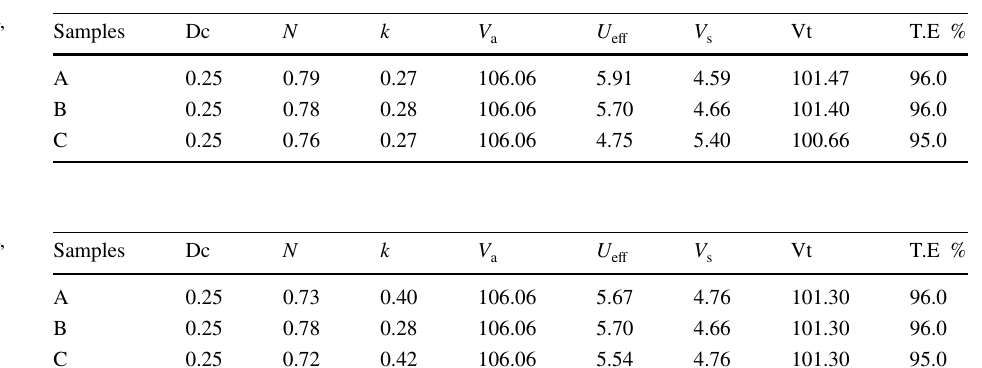
Table 20 Evaluation of V V s and T.E using 10 g